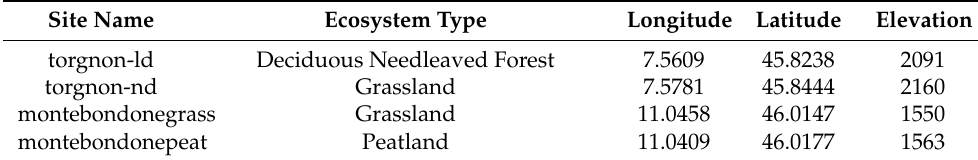
Table 3. PhenoCam network